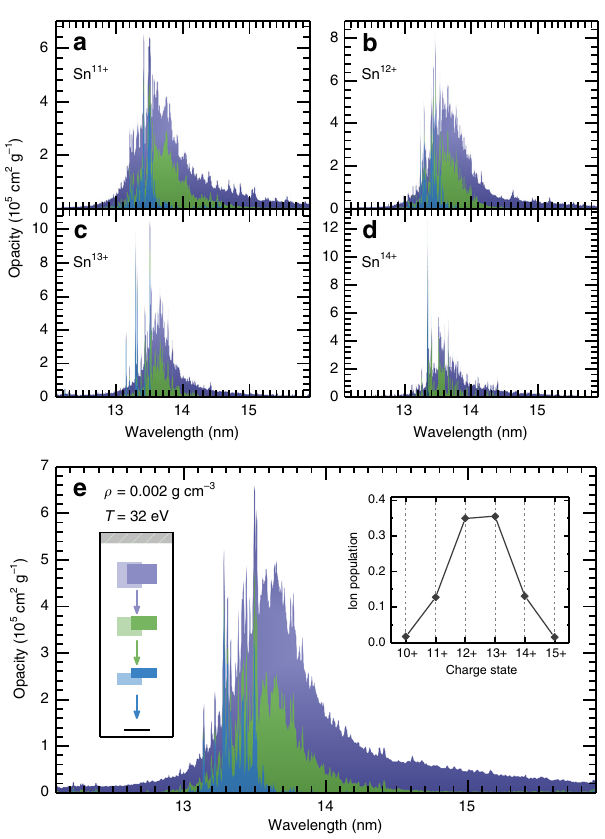
Fig. 3 Opacity spectra of tin ions. Calculations were performed for a 32 eV, 0.002 g cm − 3 Sn plasma in local thermodynamic equilibrium. The shaded areas represent the cumulative contributions (that is the next contribution is plotted stacked on top of the previous one) stemming from different types of excited states. They are divided according to the energy of the lower state into which the ions radiatively decay: in blue, transitions into the ground state manifold (from single-electron excited states); in green, transitions into levels with energies between 0 and 150 eV (comprising mainly transitions between singly- and doubly-excited states); in purple, transitions occurring between doubly-excited states (lying above 150 eV) and higher-lying multiply-excited states. a – d Opacity spectra of the individual Sn ions. e Total opacity spectrum. The left inset contains the simpli fi ed atomic structure of Sn 13 + (see Fig. 2 and main text), while the right inset shows the relative charge state population of the plasma. All spectra are convoluted with a Gaussian pro fi le to improve the visibility of the various